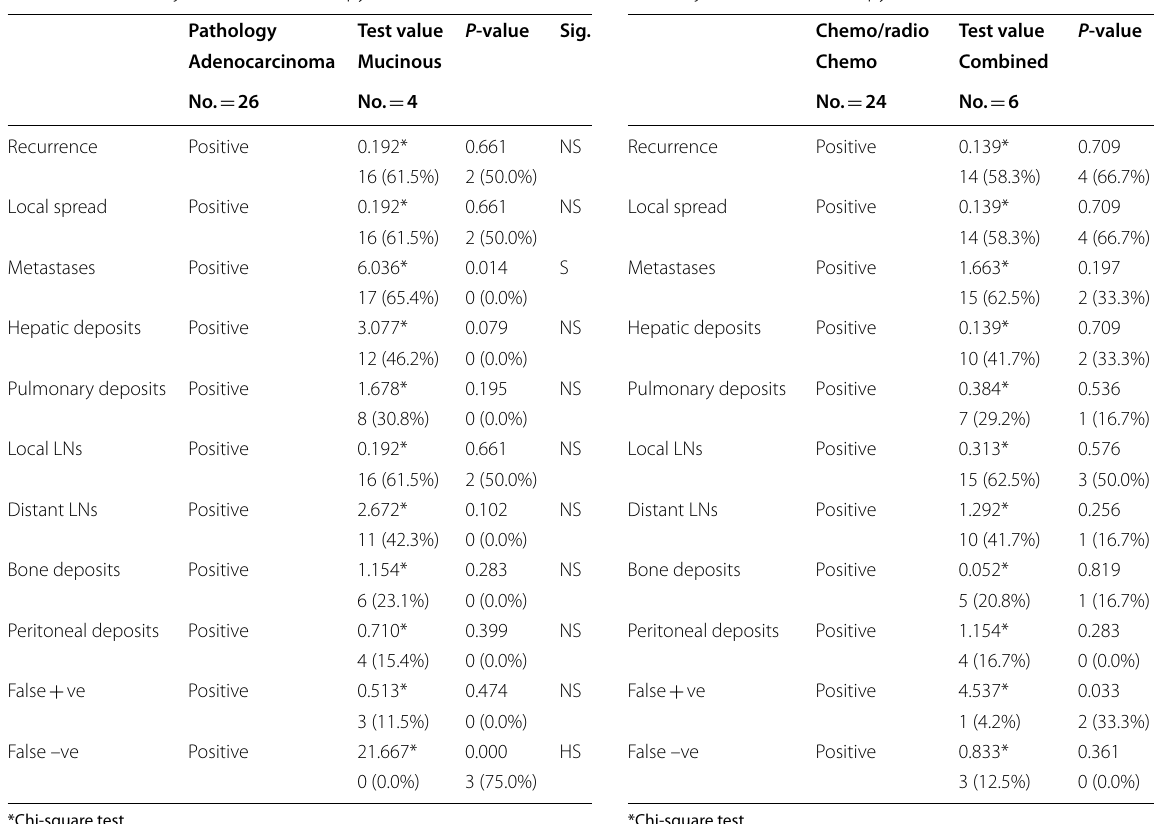
Table 5 Relation of treatment of the studied patients with PET-CT findings in follow up patients with colorectal carcinoma after adjuvant